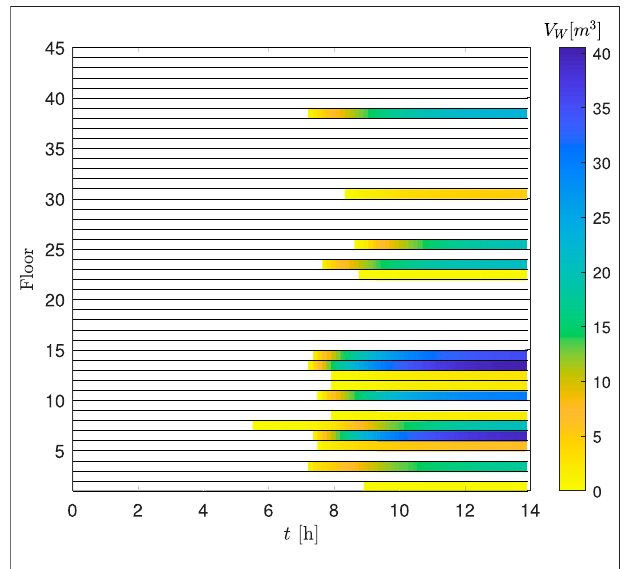
FIGURE 7 | Time histories of the water ingress at each fl